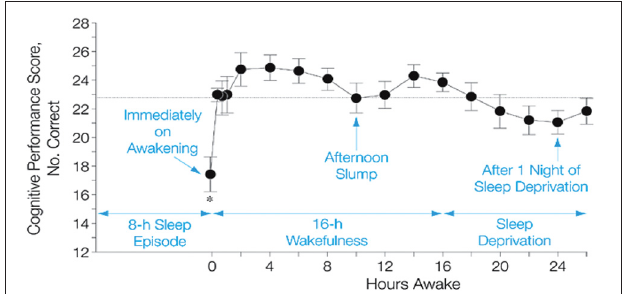
FIGURE 2 | Typical pattern of cognition across the day and one night of total sleep deprivation. Sleep inertia initially impairs cognition following the transition from sleep to wakefulness. Cognition improves rapidly within the first 20min following awakening and continues to improve over the first ∼ 2–4h of wakefulness. Cognition remains high for the first ∼ 8h awake, often followed by a midafternoon dip in cognition and then improved cognition until immediately before habitual bedtime. Cognition is impaired by staying awake overnight. Horizontal line represents the average performance across the day. Reprinted with permission from (Wertz et al.,